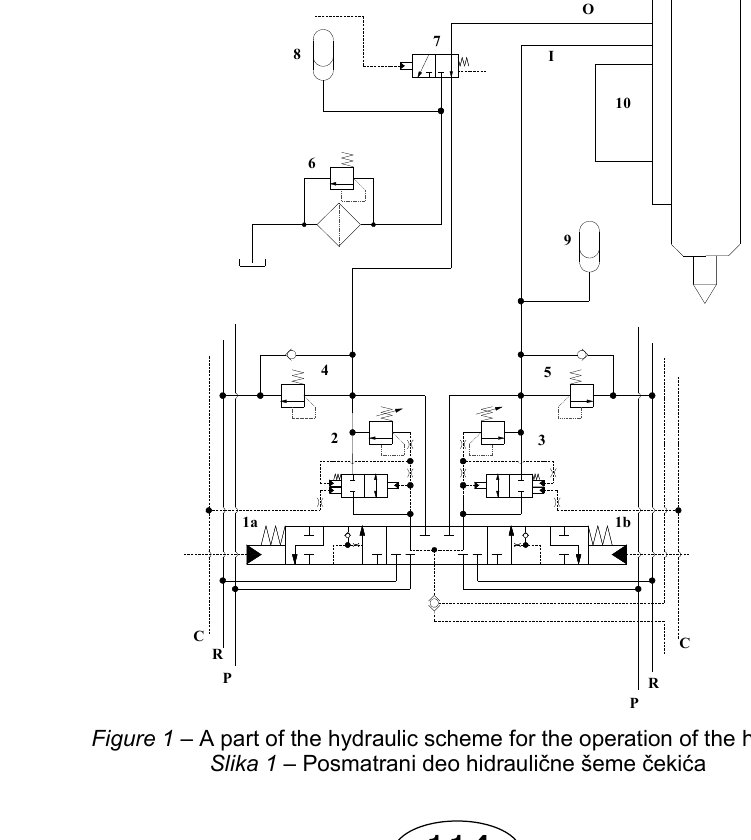
Figure 1 – A part of the hydraulic scheme for the operation of the hammer Slika 1 – Posmatrani deo hidrauli č ne šeme č eki ć